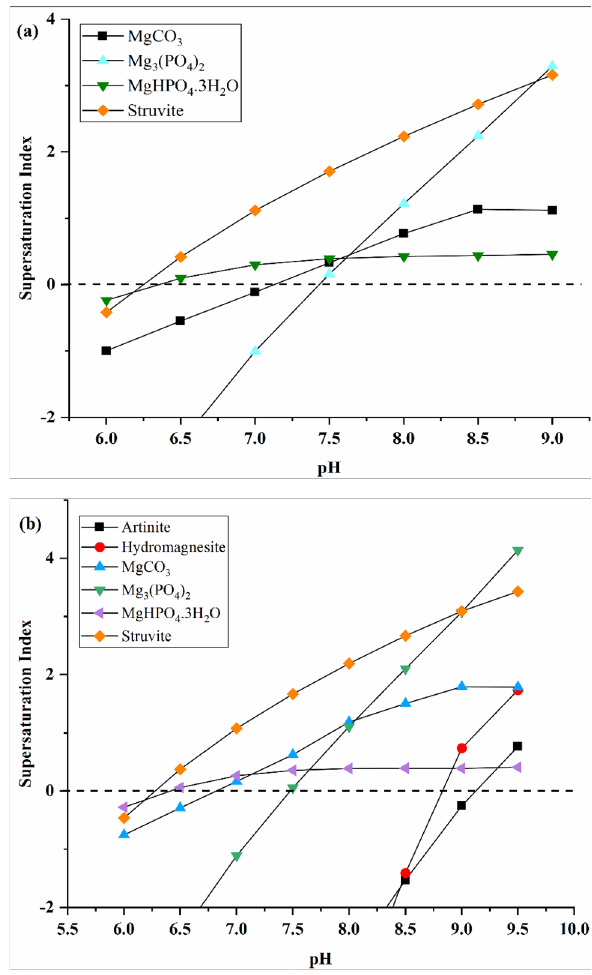
Figure 3. Supersaturation index ( SI ) of different compounds that can be formed from ions present in the synthetic supernatant as a function of pH (without lignin addition) with an alkalinity of ( a ) 1590 and ( b ) 3000 mg/L as CaCO 3 .